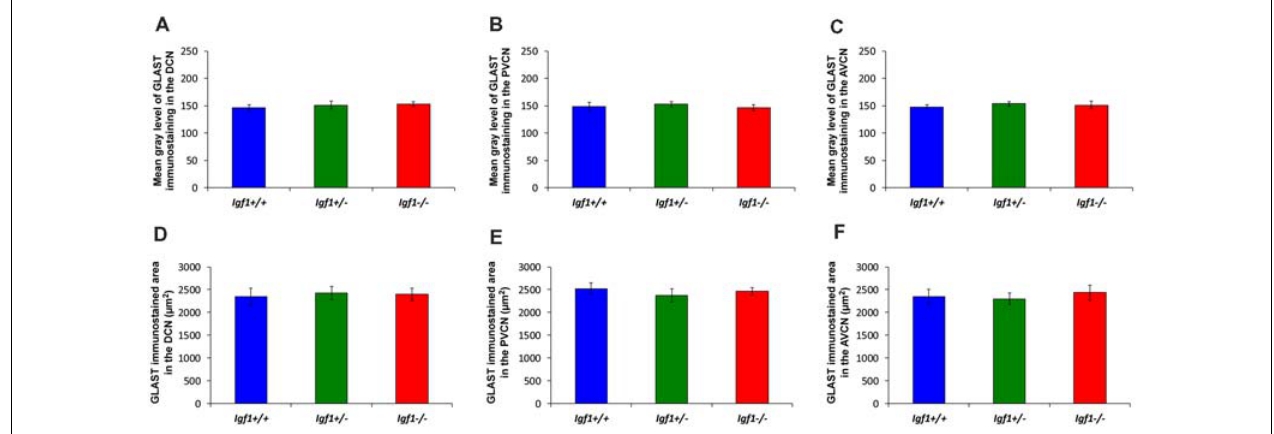
FIGURE 10 | Histograms showing the mean gray levels of GLAST immunostaining and the immunostained areas in the cochlear nuclei of Igf1 − / − , Igf1 + / − and Igf1 + / + mice. Analysis of the immunostaining indicated that there were no significant differences among the genotypes in either the mean gray levels of immunostaining (A–C) or in the immunostained areas (D–F) in the DCN, PVCN and AVCN. The error bars indicate the standard deviations of the mean.